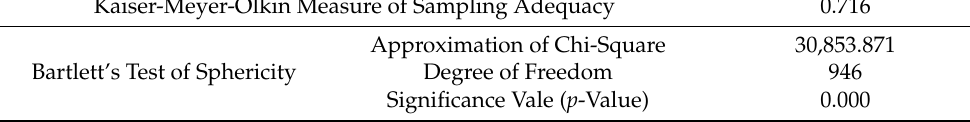
Table 4. KMO and Bartlett’s Tests.